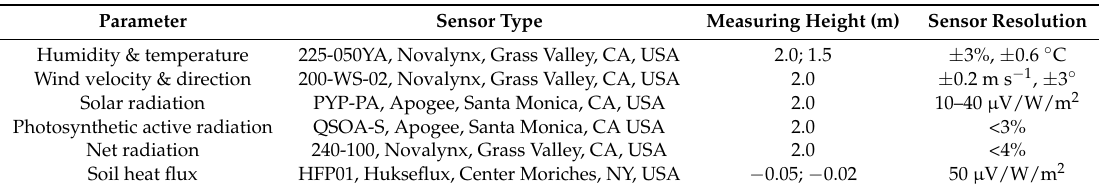
Table 1. Type of sensor, measurement height, and resolutions of the equipment in Bowen ratio